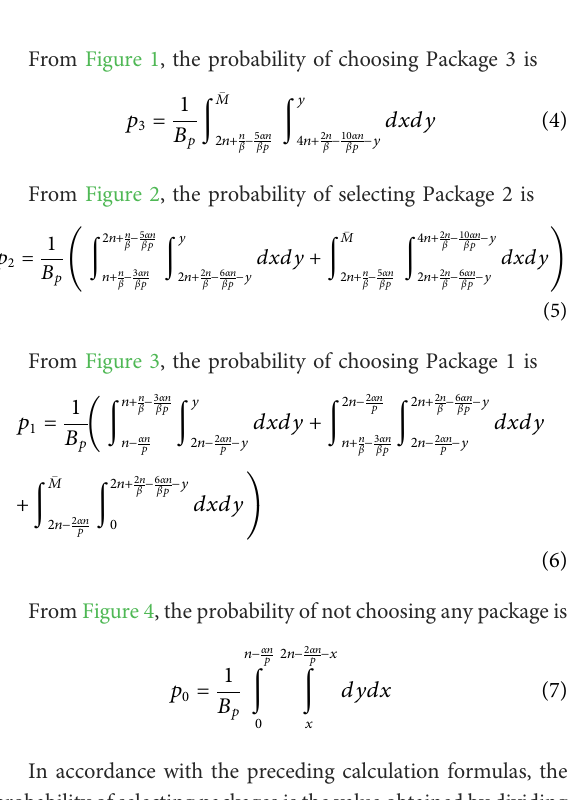
FIGURE 3 Users who choose Package